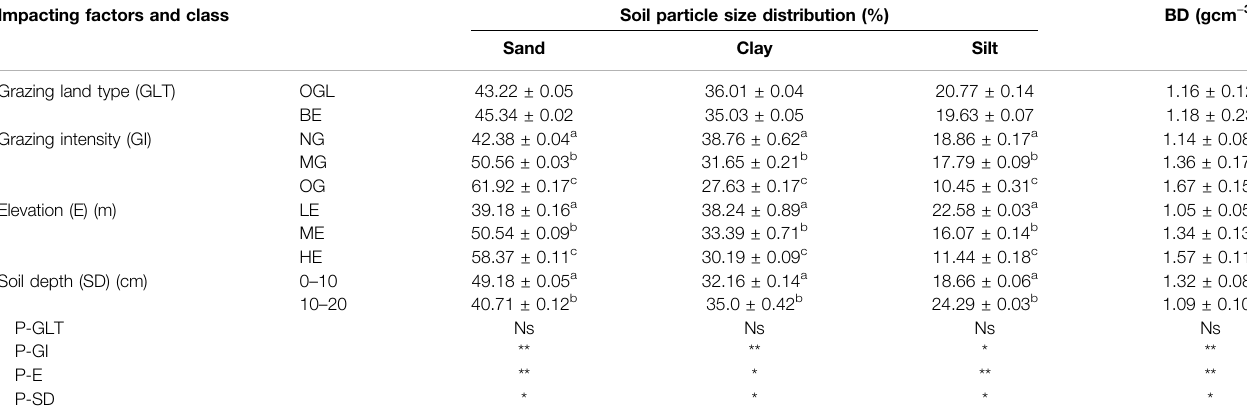
Meanvalueswithincolumnsundereachtopicfollowedbydifferentlettersaresigni fi cantlydifferentfromeachotherat p < 0.05,OGL (cid:1) open-grazingland,BE,bushencroached;NG,non- grazing;MG,moderatelygrazing;OG,overgrazing;LE,lowerelevation;ME,middleelevation;HE,higherelevation;BD,bulkdensity;ns,nonsigni fi cant,*signi fi cant,**highlysigni fi cant.SE (cid:1) standard